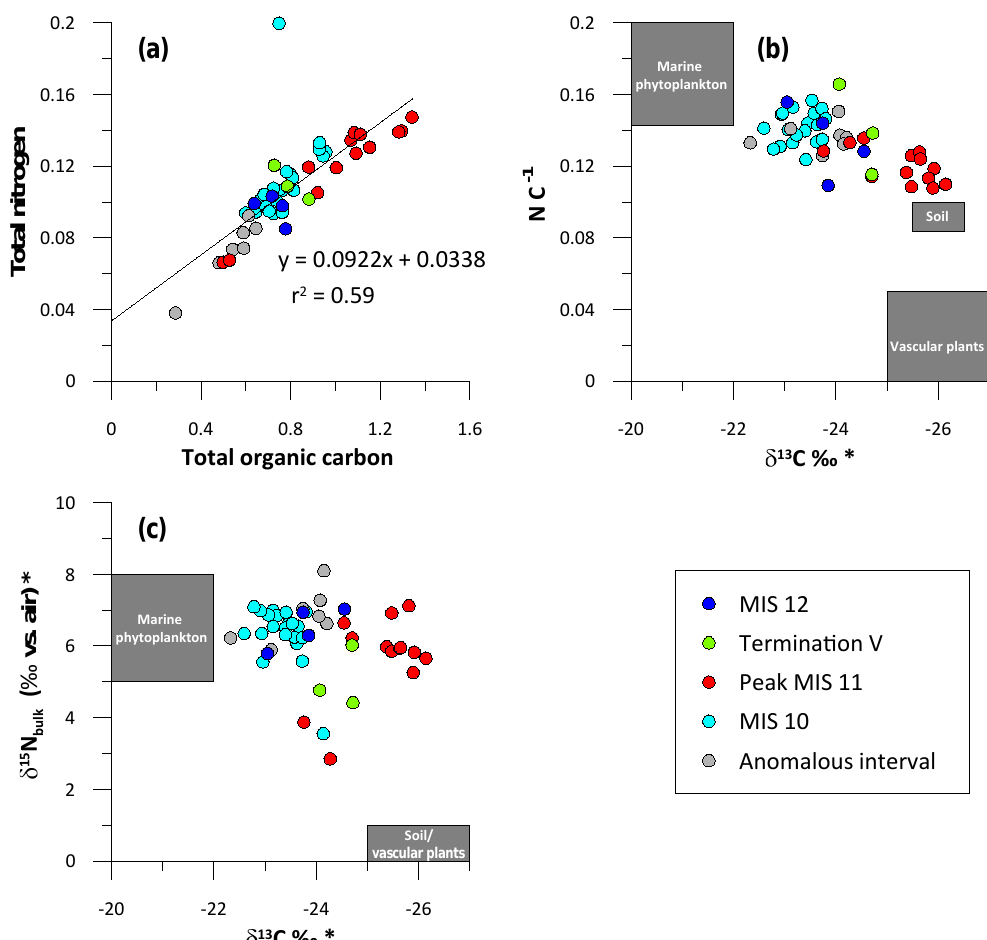
Figure 8. Cross plots of (a) total nitrogen vs. total organic carbon, (b) N / C org vs. δ 13 C, and (c) δ 15 N vs. δ 13 C. For each panel, the range of composition of each organic matter source is plotted in a grey box: marine phytoplankton (C / N: 5–7 – Redfield, 1963; Meyers, 1994; δ 13 C: − 19 to − 22‰ – Schubert and Calvert, 2001; δ 15 N: 5 to 8‰ – Walinsky et al., 2009); Soil (C / N: 10–12, δ 13 C: − 25.5 to − 26.5‰, δ 15 N: 0 to 1‰ – Walinsky et al., 2009); C3 vascular plants (C / N: >20 – Redfield, 1963; Meyers, 1994; δ 13 C: − 25 to − 27‰ –